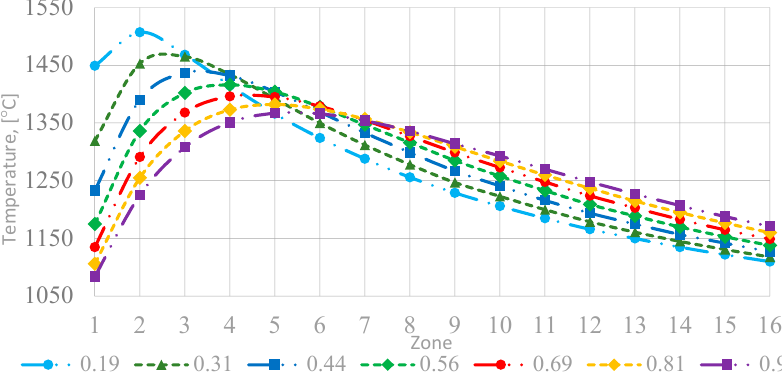
Figure 6. The change of the temperature of the flue gases during their movement in the heating furnace at various values of the dimensionless length of the heat-release volume